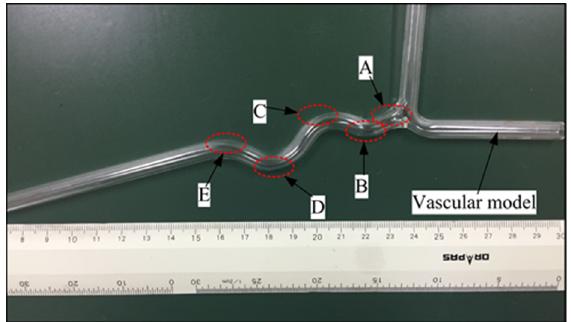
Figure 15. A vascular model for evaluating the dynamic characteristic.